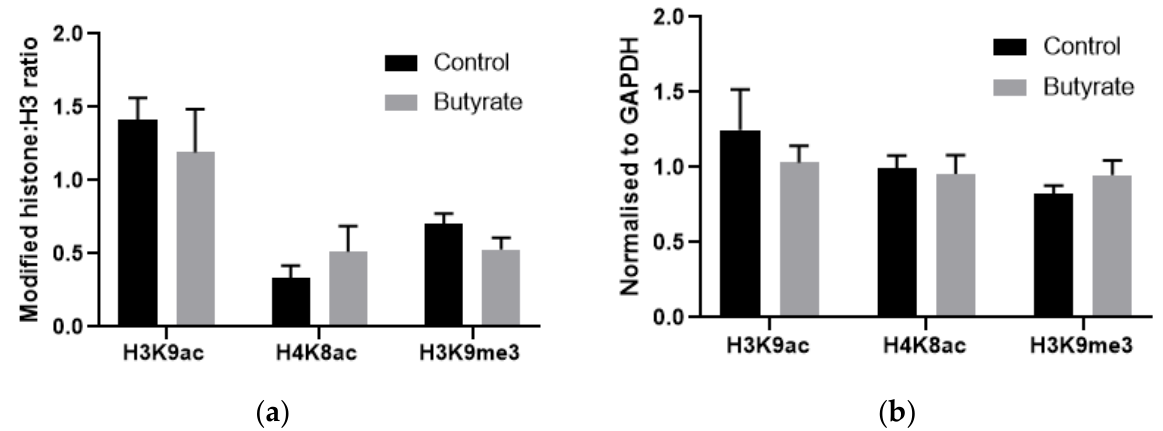
Figure 8. ChIP-qPCR results in proximity to HK1 normalised to ( a ) total H3 or ( b ) control gene values from HepG2 cells treated with 5 mM butyrate for 24 h. Results represent the mean combined from four independent experiments, with error bars representing SEMs.